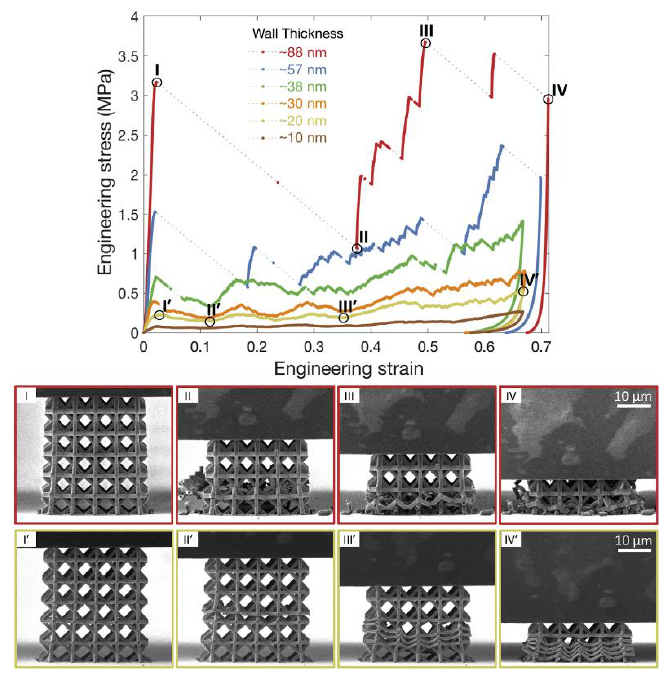
Figure 6. The engineering stress – strain curves of the hollow Zr-Ni-Al MG lattice structures, where the SEM images below were taken at the stages indicated by the circles in the curves. Reprinted from [18] with copyright permission from Elsevier, 2017.